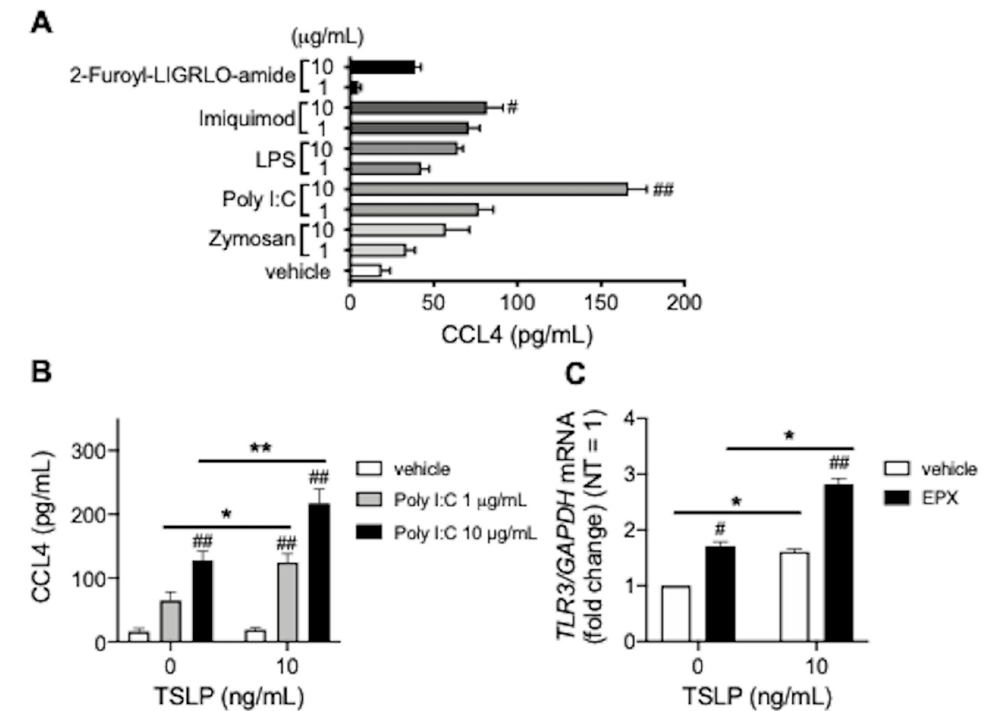
Figure 2. TLR3 ligand-mediated CCL4 release. ( A ) CCL4 release from BEAS-2B cells stimulated overnight with TLR ligands (zymosan, poly I:C, LPS, imiquimod), and the PAR2 agonist (2-Furoyl- LIGRLO-amide). ( B ) CCL4 release from BEAS-2B cells co-incubated overnight with TSLP and poly I:C. ( C ) TLR3 mRNA levels in BEAS-2B cells incubated with TSLP for 48 h, followed by overnight stimulation with EPX (10 µg/mL). Values represent the mean ± standard error of the mean from four ( A , B ) or three ( C ) experiments; # p < 0.05, ## p < 0.01 (vs. vehicle in each group), * p < 0.05, ** p < 0.01 (as shown between the two groups).